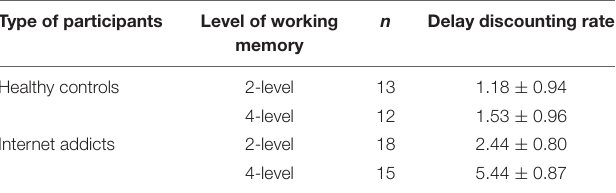
TABLE 2 | Descriptive statistics for delay discounting rate according to participant type and level of difficulty in working memory task ( M ± SD ).